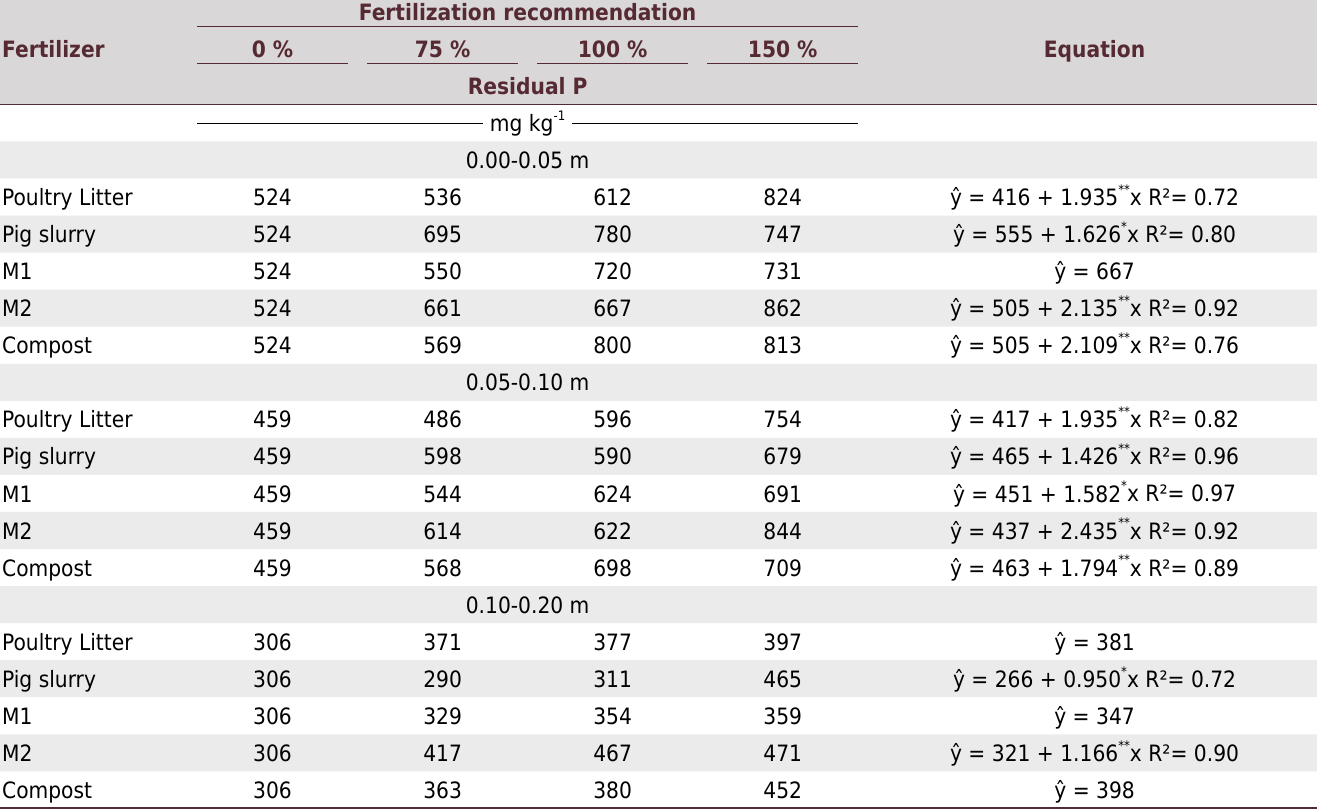
Table 8. Residual soil phosphorus in the 0.00-0.05, 0.05-0.10, and 0.10-0.20 m layers after six years use of organic and mineral fertilizers in a Rhodic Kandiudox